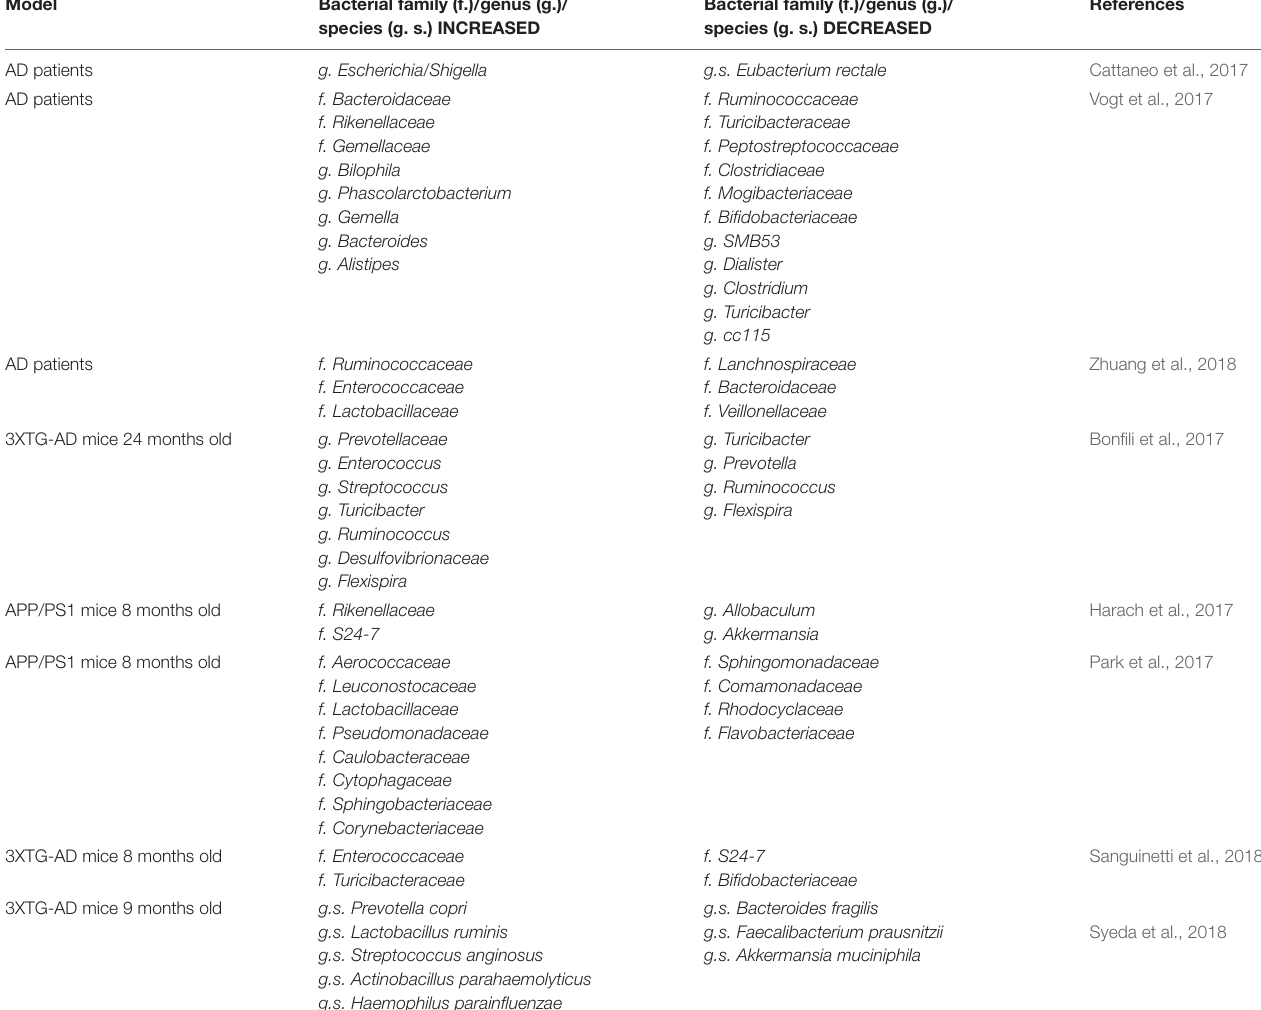
TABLE 2 | Alterations in gut microbiota in AD patients and AD mice at FAMILY, GENUS, and SPECIES levels. Model Bacterial family (f.)/genus (g.)/ Bacterial family (f.)/genus (g.)/ species (g. s.) INCREASED species (g. s.)